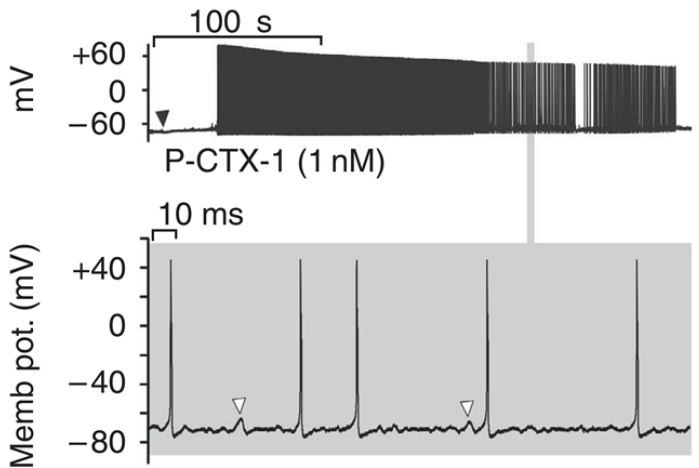
Figure 2. Spontaneous action potential firing induced by P-CTX-1 (1 nM) in cultured mouse dorsal root ganglion neurons. Upper panel: membrane depolarization followed by series of action potentials. Lower panel: expanded view showing membrane potential oscillations frequently followed by action potentials (reprinted from [111] with editor